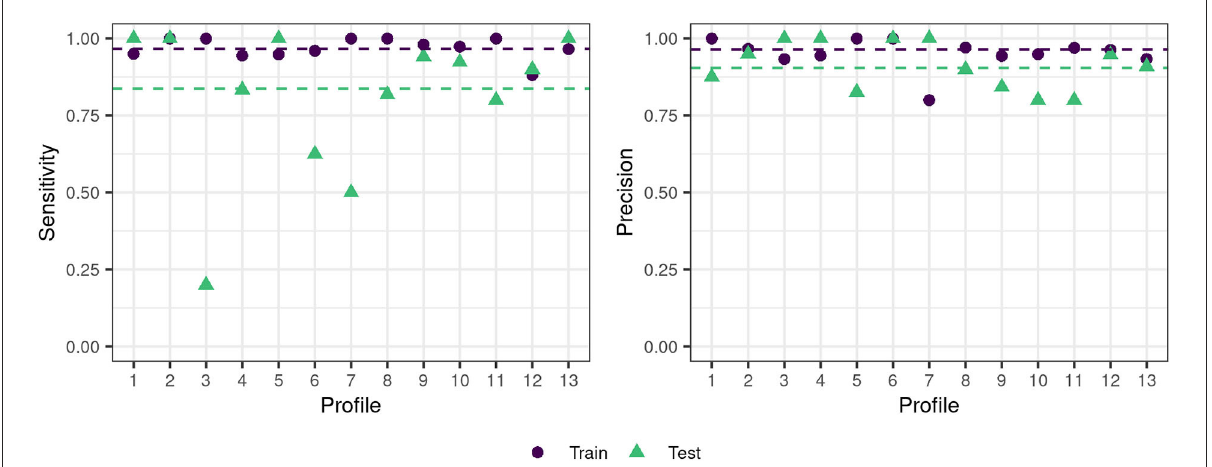
FIGURE5 Train-test data set performance for the OVAOVO (kappa, repCV model) for both sensitivity and precision. The dashed lines indicate the mean across profiles 1–6 and 8–13 for the respective